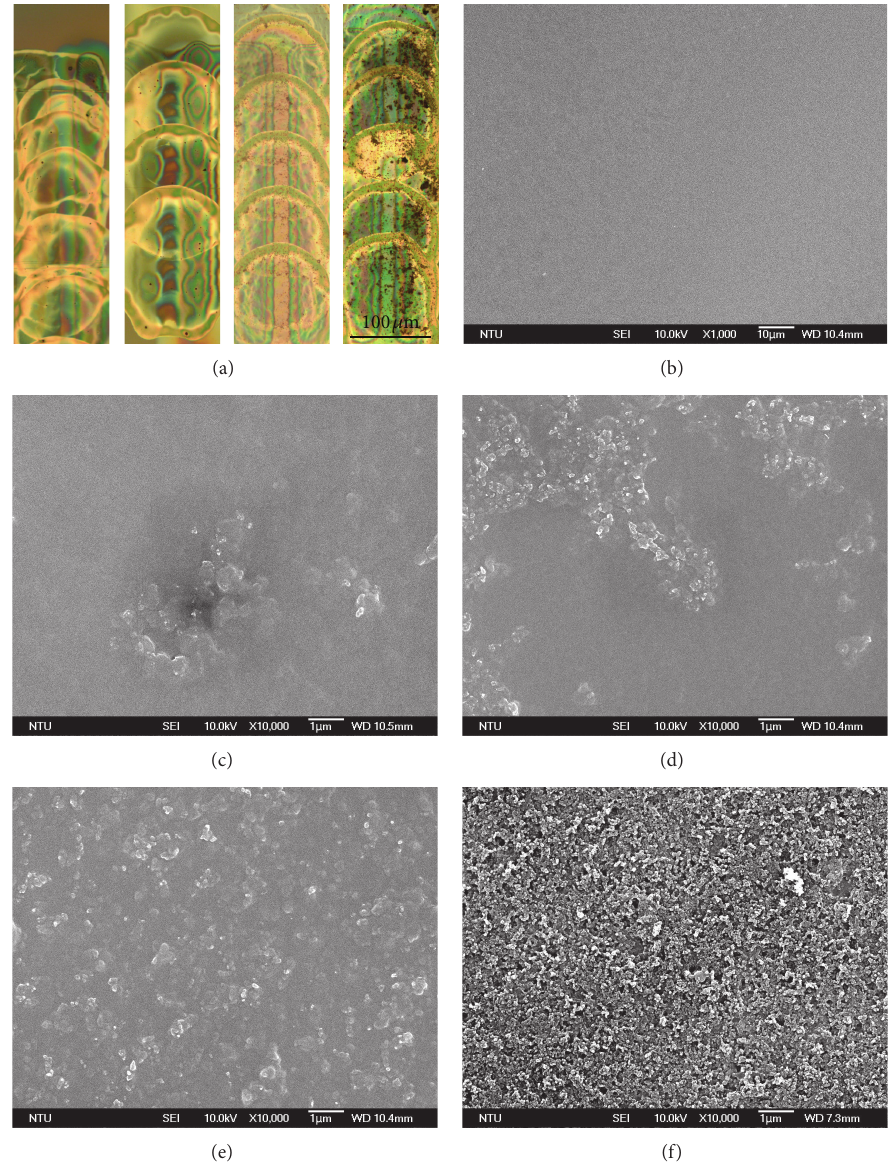
Figure 5: (a) Microscope images of channel region, from left to right, the CNP/P3HT, are 0 wt.%, 1wt.%, 5wt.%, and 10wt.%, respectively. SEM images for (b) pristine P3HT, (c) CNP/P3HT = 1wt.%, (d) CNP/P3HT = 5 wt.%, (e) CNP/P3HT = 10wt.%, and (f) CNP/P3HT = 43 wt.%.